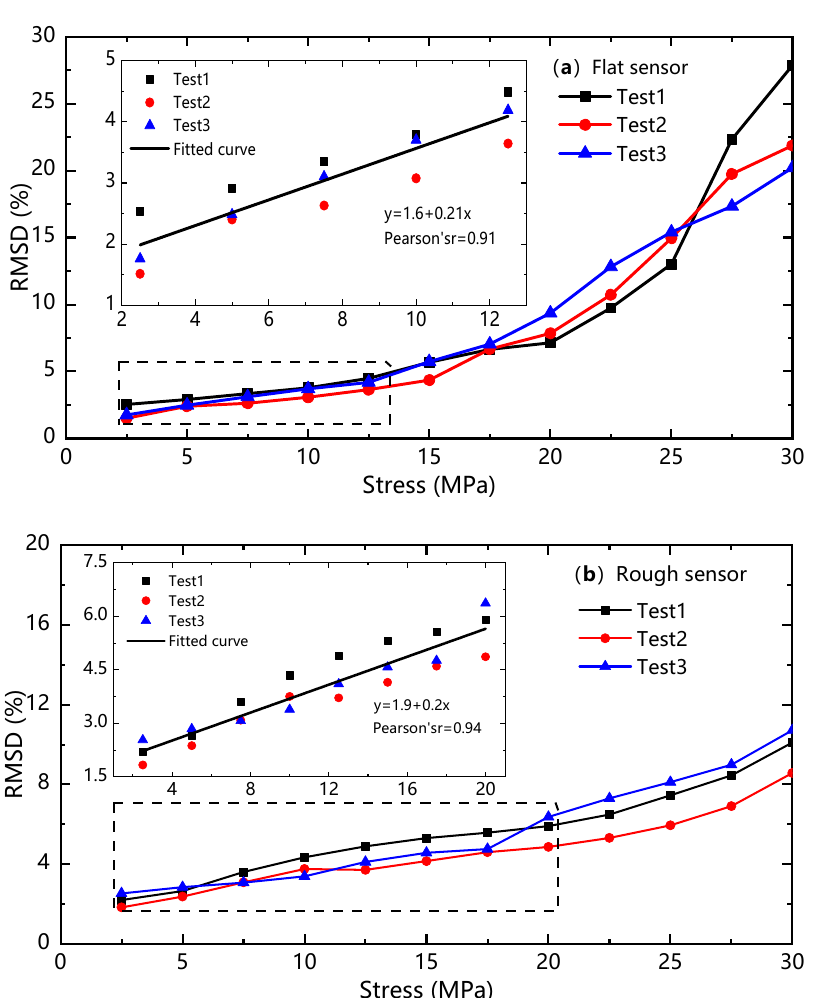
Figure 14. RMSD indices calculated from the conductance signatures for the PZT sensors with ( a ) flat and ( b ) rough interfaces.